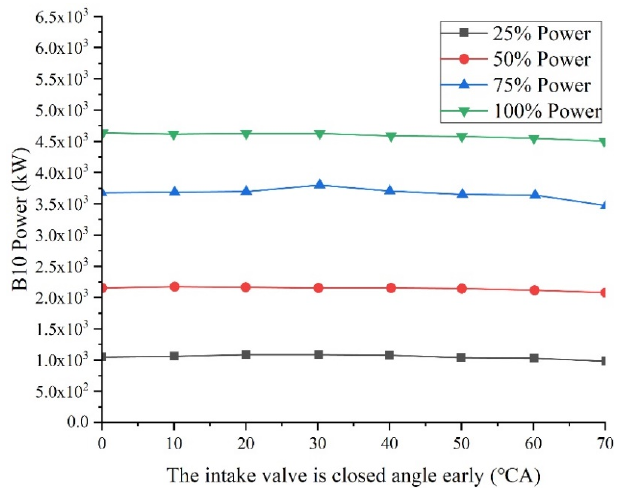
Figure 14. The effect of power influence when Miller degree > 0.